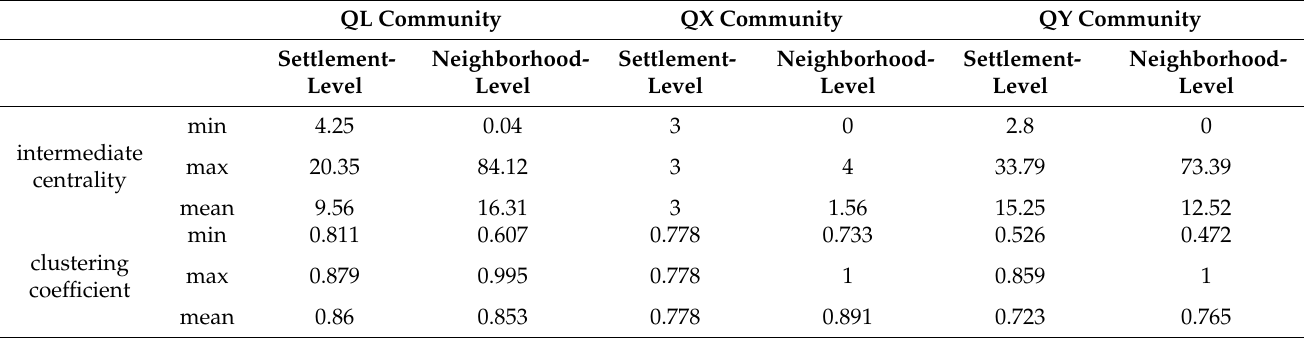
Table 6. Node parameter statistics of public spaces within affordable housing areas as typical samples.